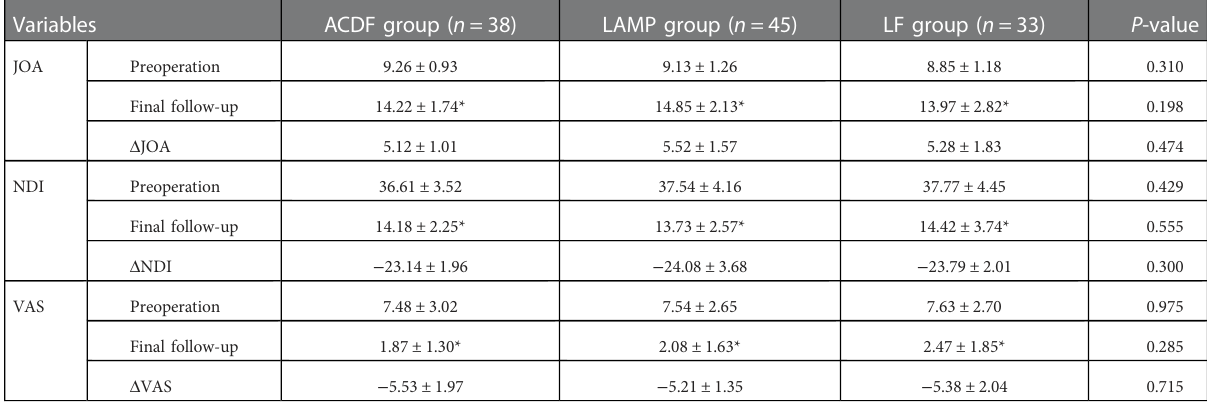
TABLE 2 Clinical outcomes in each group.